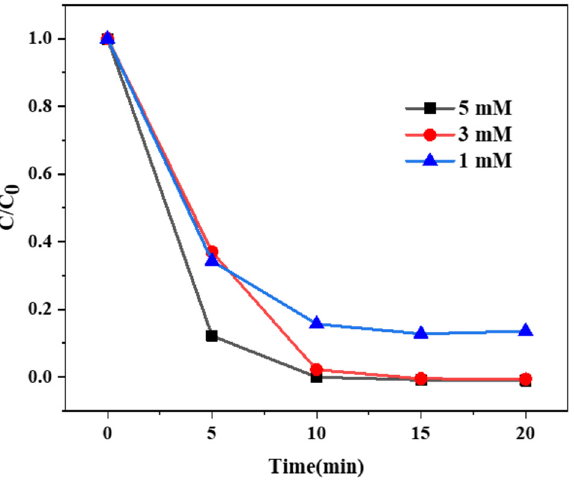
Figure 6. Effect of PMS concentration on OG degradation. Condition: [OG] = 50 mg/L, [ZVC] = 0.3 g/L.